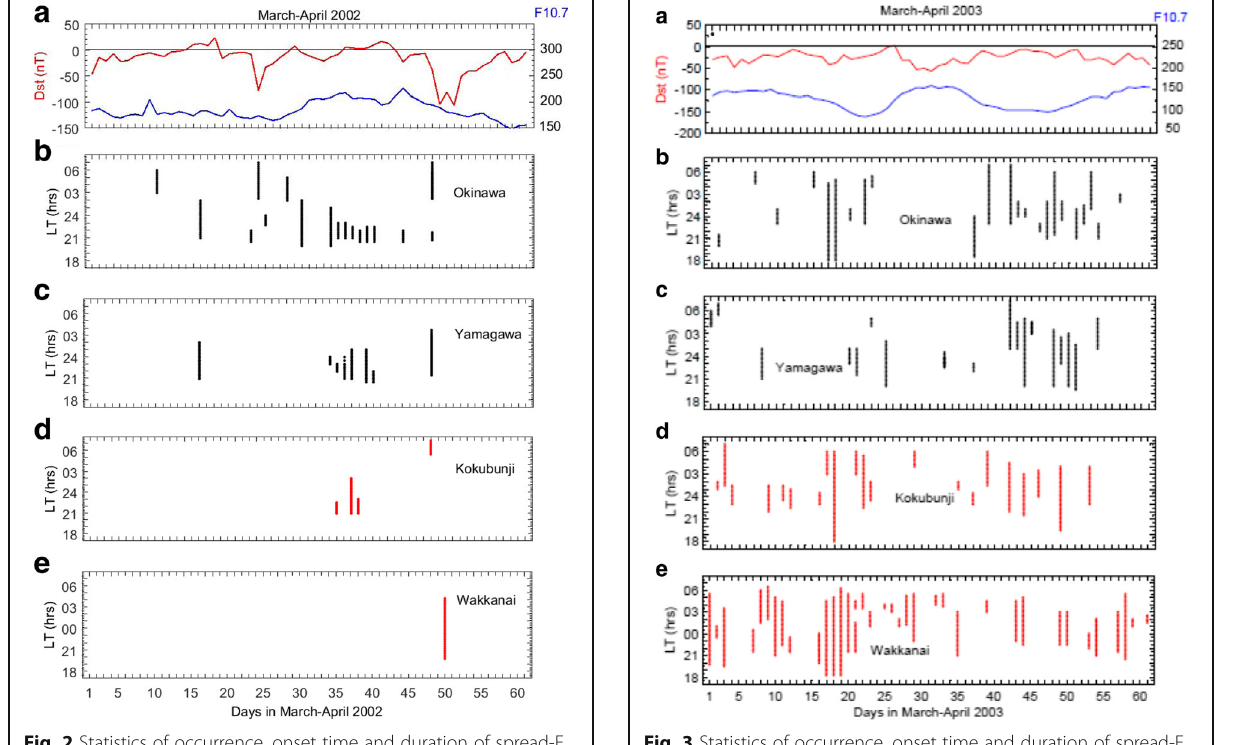
Fig. 2 Statistics of occurrence, onset time and duration of spread-F at b Okinawa, c Yamagawa, d Kokubunji and e Wakkanai in March to April 2002; black bars indicate range type spread-F, and red bars indicate frequency type spread-F. a Daily mean magnetic and solar activity indices (Dst and F10.7)